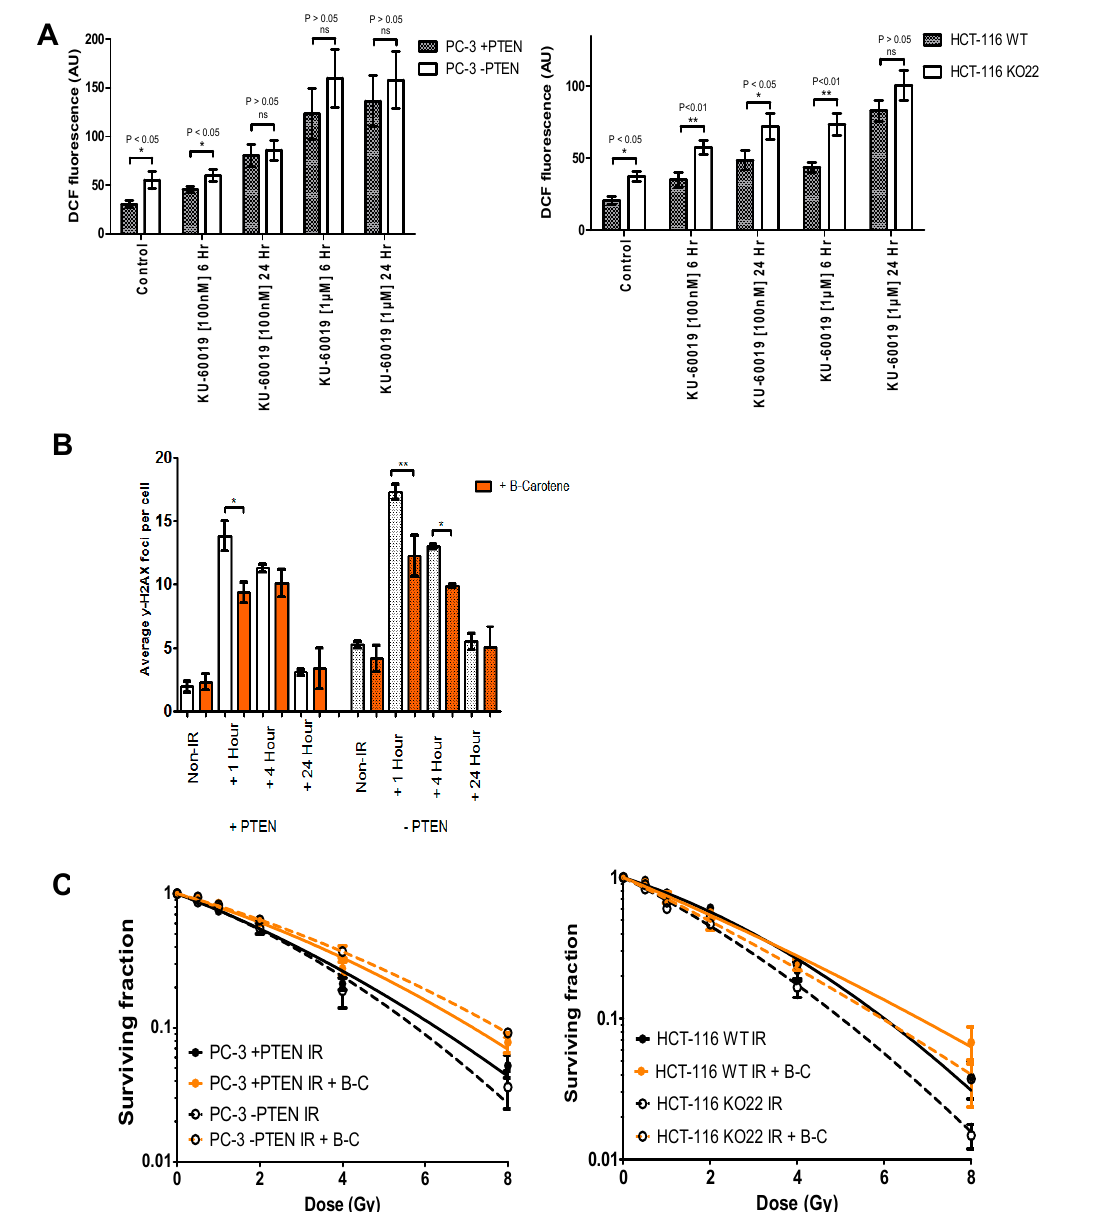
Figure 5. Role of reactive oxygen species and its dependency on PTEN status and combinations of radiation with KU-60019. ( A ) Quantification of reactive oxygen species (ROS) levels in PTEN isogenic cell models following KU-60019 treatment. ROS levels in PC-3 and HCT-116 +PTEN and − PTEN cells were measured basally and following treatment with 100 nM or 1 µM KU-60019. Measurements were performed by DCF-DA fluorescence assay 6 and 24 h post-treatment with the mean fluorescence levels for each group shown. AU, Arbitrary units. Differences between two groups were compared by using a two-sample student’s t-test. ( B ) Mean γ -H2AX foci per cell for PC-3 +PTEN and − PTEN cells 1, 4, and 24 h post-treatment with 1 Gy IR or 1 Gy IR following beta-carotene exposure. Asterisks indicate the level of statistical significance (one asterisk (*), p < 0.05; two asterisks (**), p < 0.01). ( C ) Clonogenic survival curves showing the effect of beta-carotene on radiosensitivity of +PTEN ( ● ) and − PTEN ( ■ ) HCT-116 and PC-3 cell models compared to controls ( ● ) and ( ■ ) respectively. Cell media was treated with beta-carotene 2 h before they were irradiated with a single radiation dose of 0.5, 1, 2, 4, or 8 Gy.